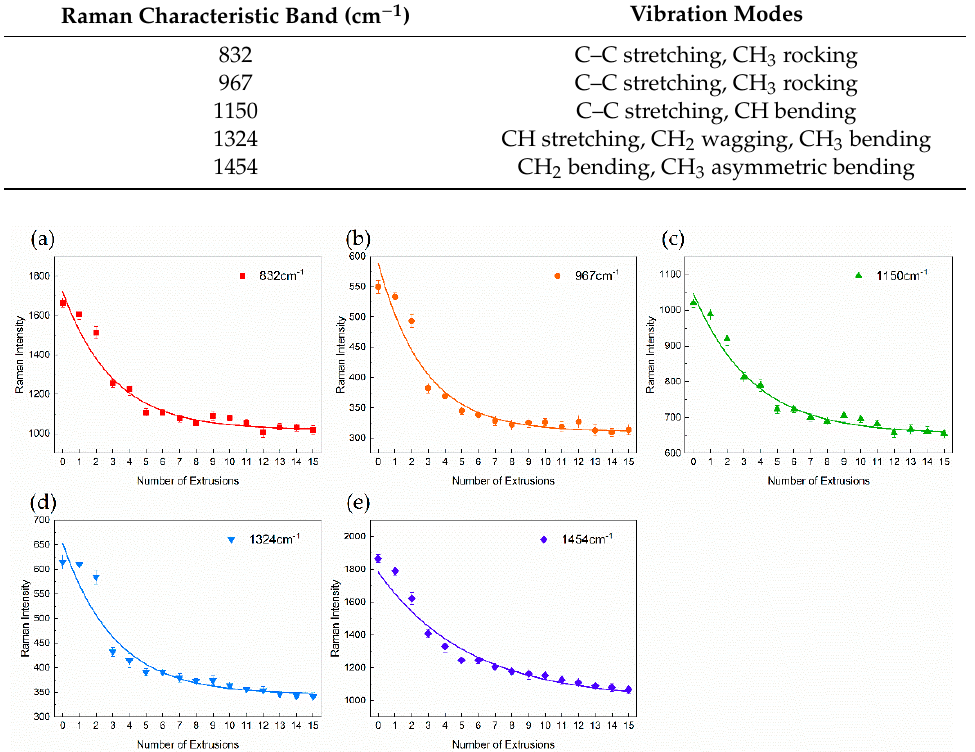
Figure 3. Variations and fitting curves of Raman intensity in PP main characteristic bands with di ff erent numbers of extrusions. ( a ) 832 cm − 1 , ( b ) 967 cm − 1 , ( c ) 1150 cm − 1 , ( d ) 1324 cm − 1 , ( e ) 1454 cm − 1 .